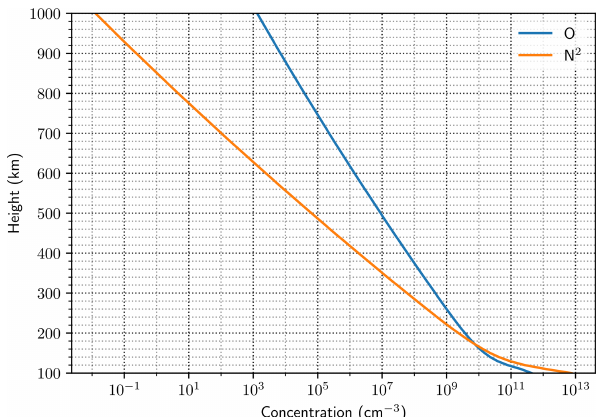
Figure 5. An NRLMSISE model of the nitrogen and atomic oxy- gen contents above KHO in Longyearbyen for the time of the launch (UTC7.5). From the CCMC ModelWeb, https://ccmc.gsfc. nasa.gov/modelweb/models/nrlmsise00.php (last access: 31 Octo- ber 2017), M. Picone, A. E. Hedin and D. Drob, Naval Research Laboratory (Picone et al.,